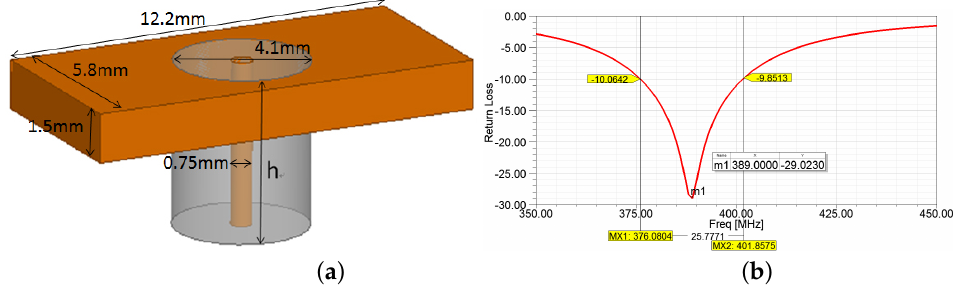
Figure 10. ( a ) A simple model of SMA connector and ( b ) the new return loss. The radiation pattern measurement was conducted in a 4 m × 4 m anechoic chamber equipped with a SATIMO SG24 system. The Antenna Under Test (AUT) was set on the top of the mast, which can rotate horizontally along the central axis. An array of 24 probes was distributed around the arch in the vertical plane driven by a control unit for electric scanning. The testing scenario is shown in Figure 12a, and the horizontal far-field radiation pattern at 403 MHz is given in Figure 12b with a maximum gain of − 18.8 dB and